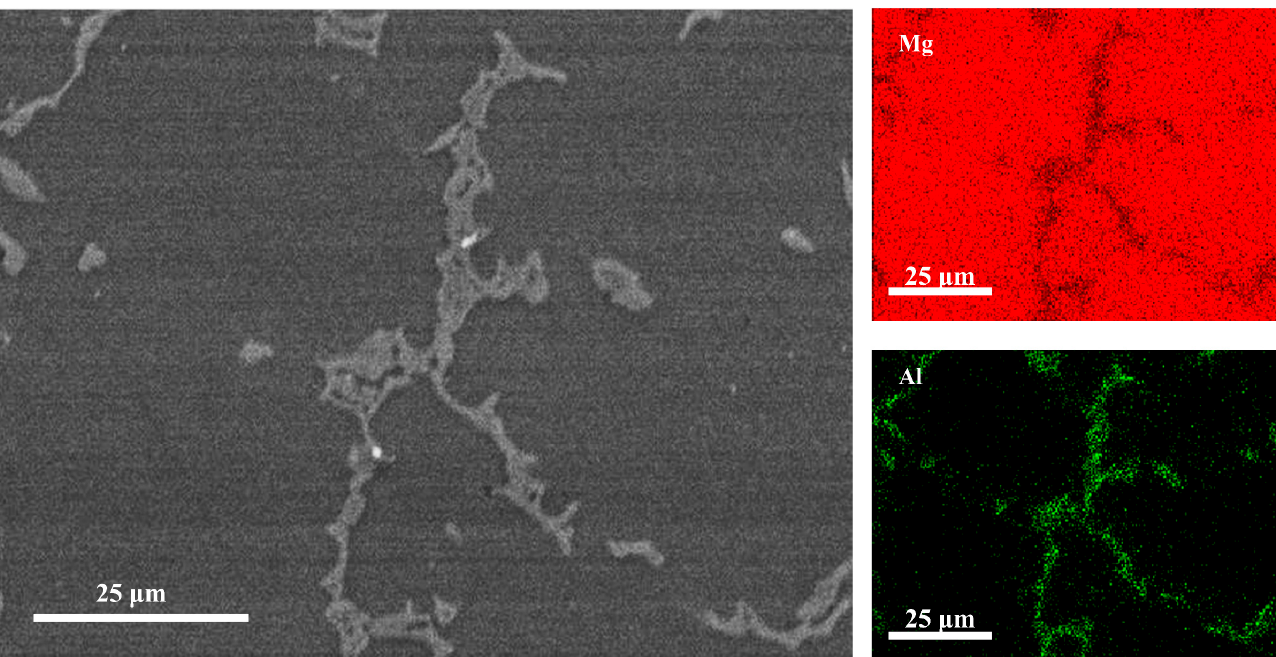
Figure 4. The EDS mapping of the second phases in AZ80.